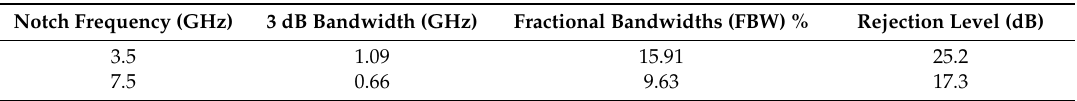
Table 4. Measurement results of the dual notched bands.